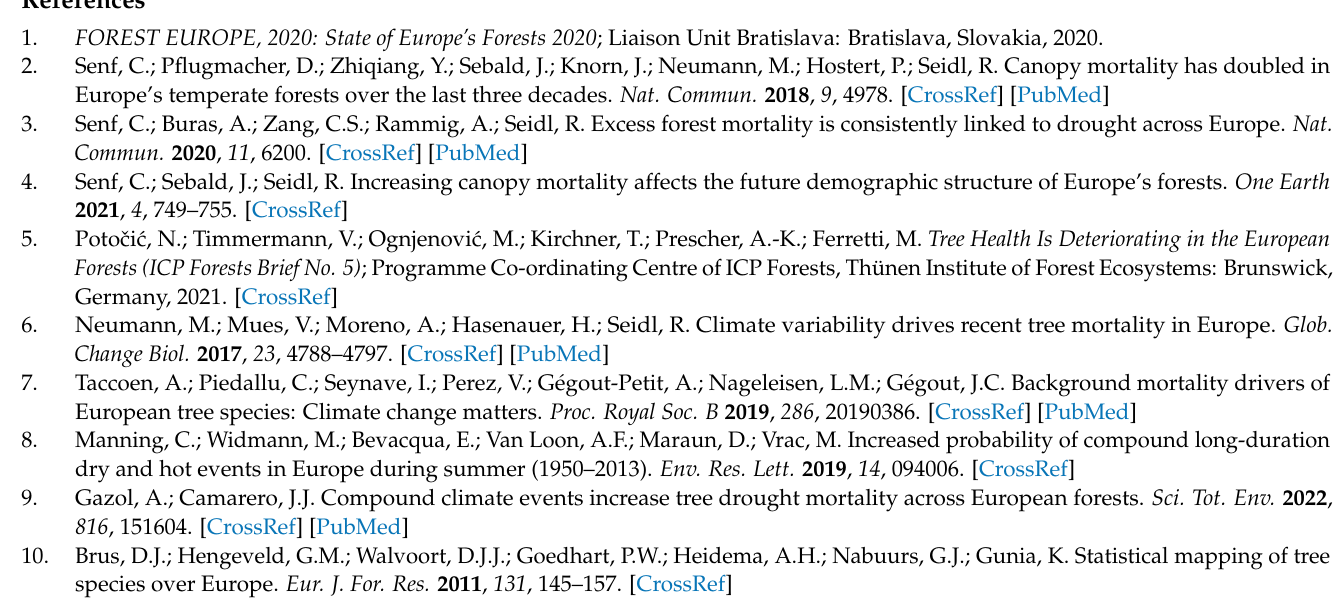
Figure A2. Presence and type of deadwood in the studied stands. The line-intercept method was used to quantify the cover and volume of deadwood in each site. The symbols located along the straight line represent deadwood with different degradation class (color scale). In addition, the position of stumps and snags was recorded up to 2.5 m away from the 100 m long transects. The symbols of varying size and form represent the position of snags and stumps with respect to transects. Colors indicate the deadwood degree of decomposition (1–5), and the size is proportional to the diameter of the stump or snag. The symbol type indicates the tree species of deadwood (circle, silver fir; diamond, other species).